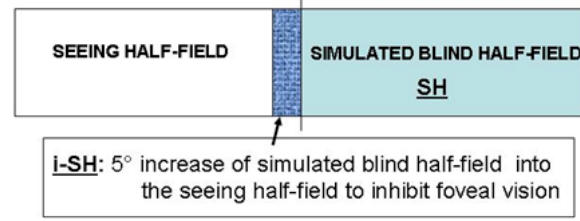
Figure 1b. SH and